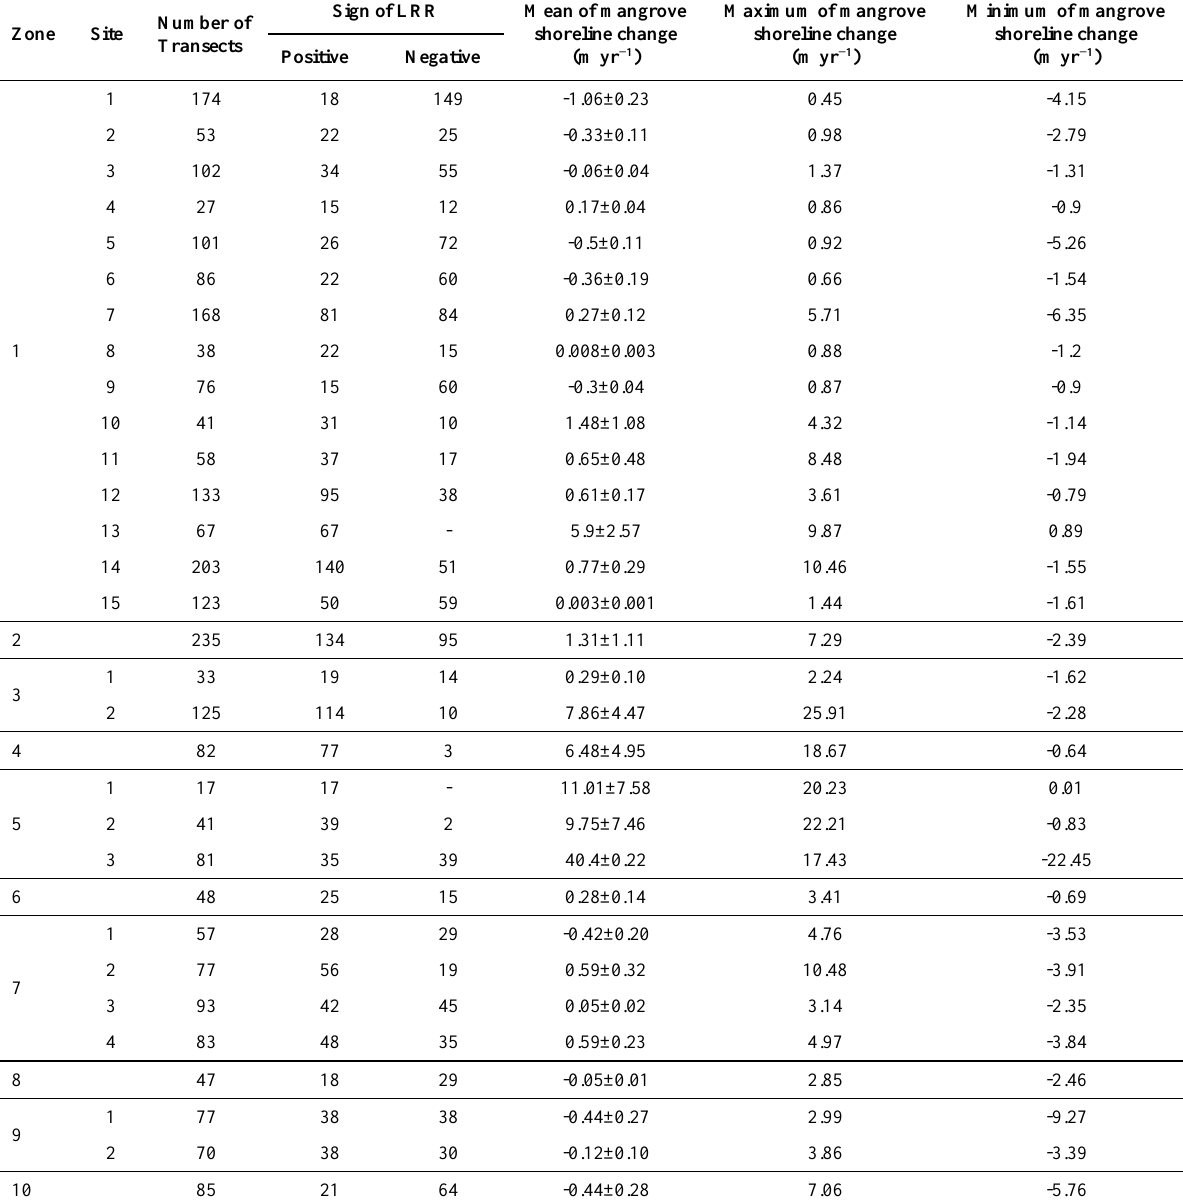
Table 2. Rates of change of mangrove shorelines in ten zones across the study